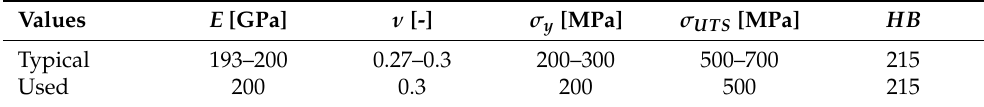
Table 1. Elastic properties of AISI 316 stainless steel [27–30]: E is Young’s modulus, ν is the Poisson’s ratio, σ y is the yield stress, σ UTS is the Ultimate Tensile Strength and HB is the maximum Brinell Hardness. The first line contains the typical values; the second line reports the chosen values for the FEM